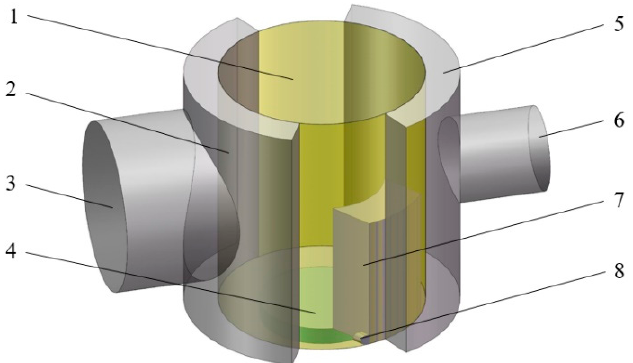
Figure 3. Fluid model of RSDF system. (1) Rotating sleeve gap; (2) Loading chamber; (3) Oil inlet; (4) Pump body; (5) Collecting chamber; (6) Oil outlet; (7) Valve port; (8) Damping groove.